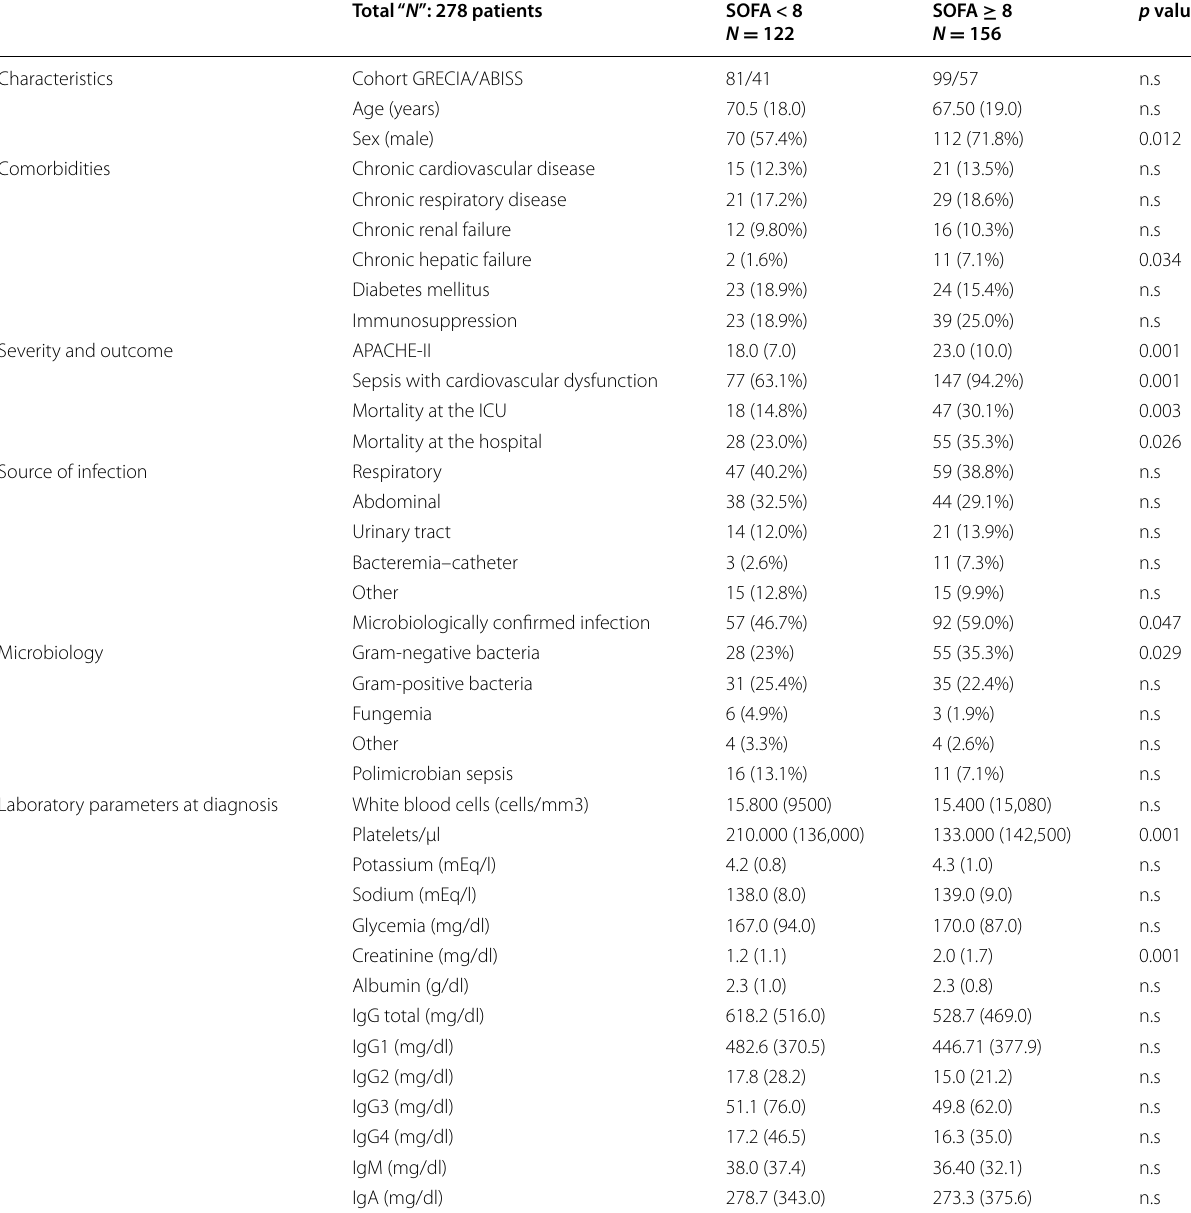
Continuous variables are shown as median (inter‑quartile rank) and categorical variables as n